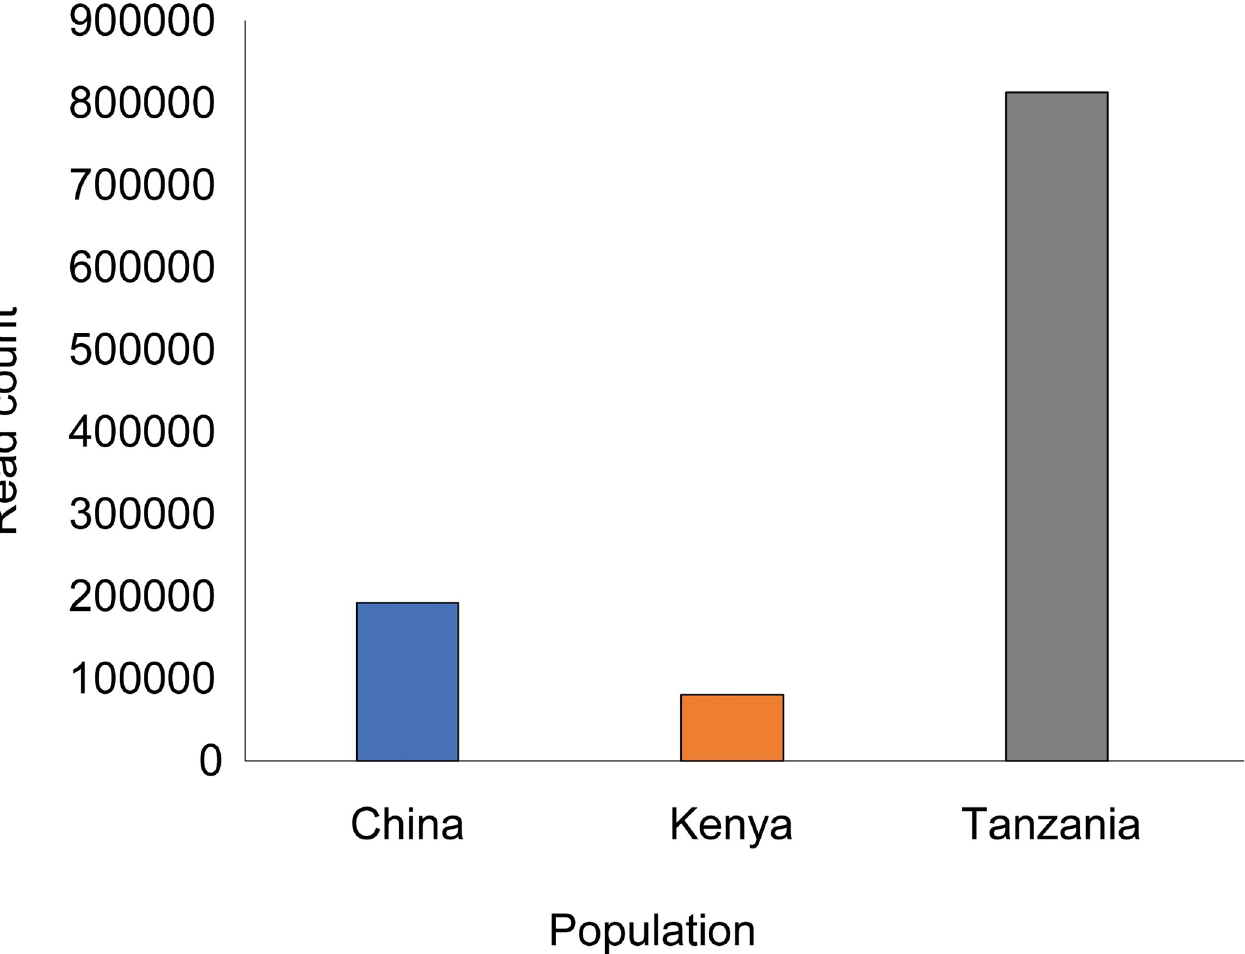
Fig 2. Overview of 16S rRNA library size for MinION sequencing of five pooled Diaphorina citri individuals collected from each world region (China, Kenya and Tanzania).